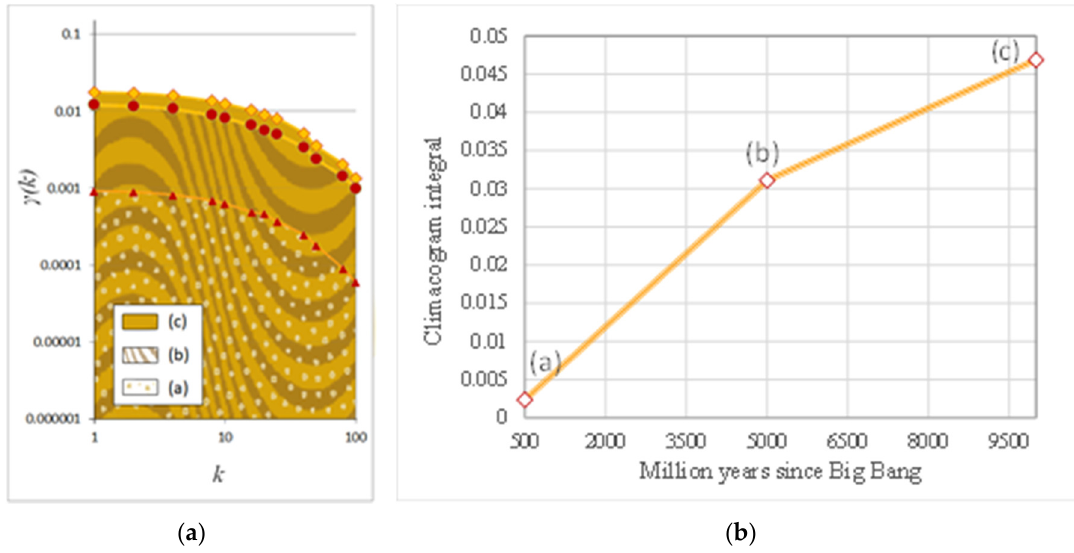
Figure 14. ( a ) Cumulative areas underneath each climacogram for each scale; ( b ) rate of alteration. Source: [39].